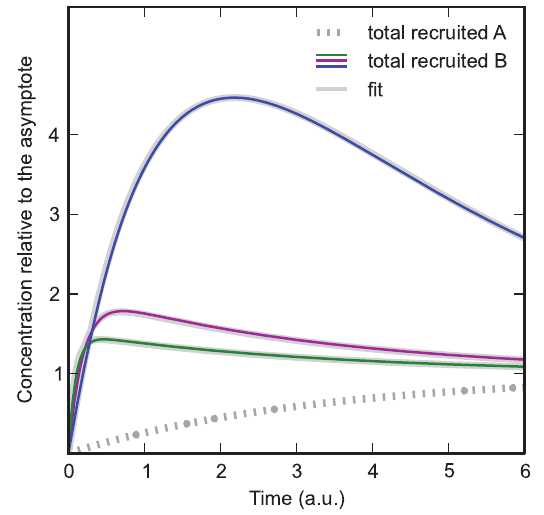
Figure 6. Model in which protein A increases the dissociation ~ k (cid:3) ~ 0 : 3 , k (cid:3) ~ 10 , 5 , 0 : 5 from green to blue rate of B . k (cid:3) S z A SB z A S z B curve, k SB { B ~ 0 and k SAB { B ~ 5 . Grey curves: Fits of the model in which protein A decreases the association rate of B and in which dissociation is relevant (section B1.3).